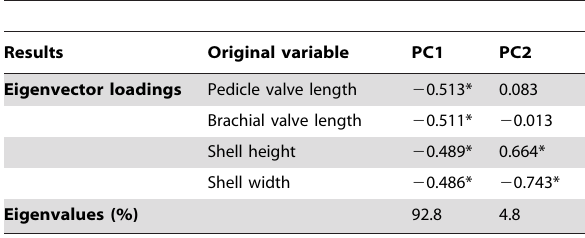
Table 2. Eigenvector loadings and eigenvalues for PCA of four linear shell measurements of Bouchardia